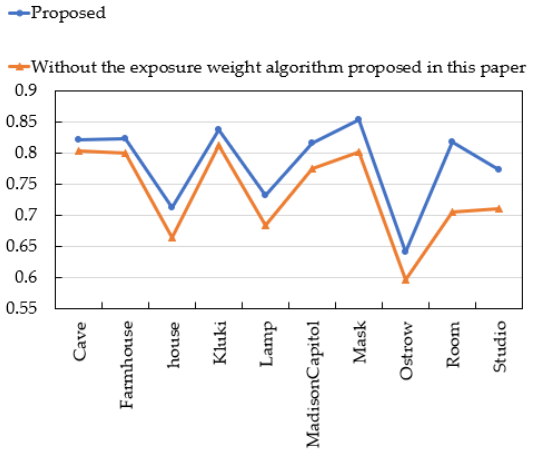
Figure 10. Q 𝐴𝐵/𝐹 comparison of the proposed and alternative exposure weighting algorithms. Figure 10. Q AB / F comparison of the proposed and alternative exposure weighting